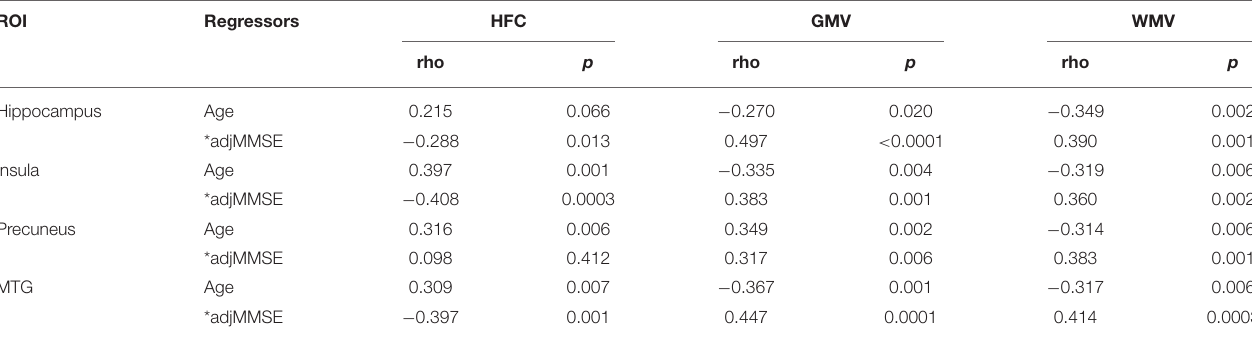
TABLE 3 | Results of correlation analyses of MRI measures with ages and Mini-Mental State Examination (MMSE) scores in the specific brain